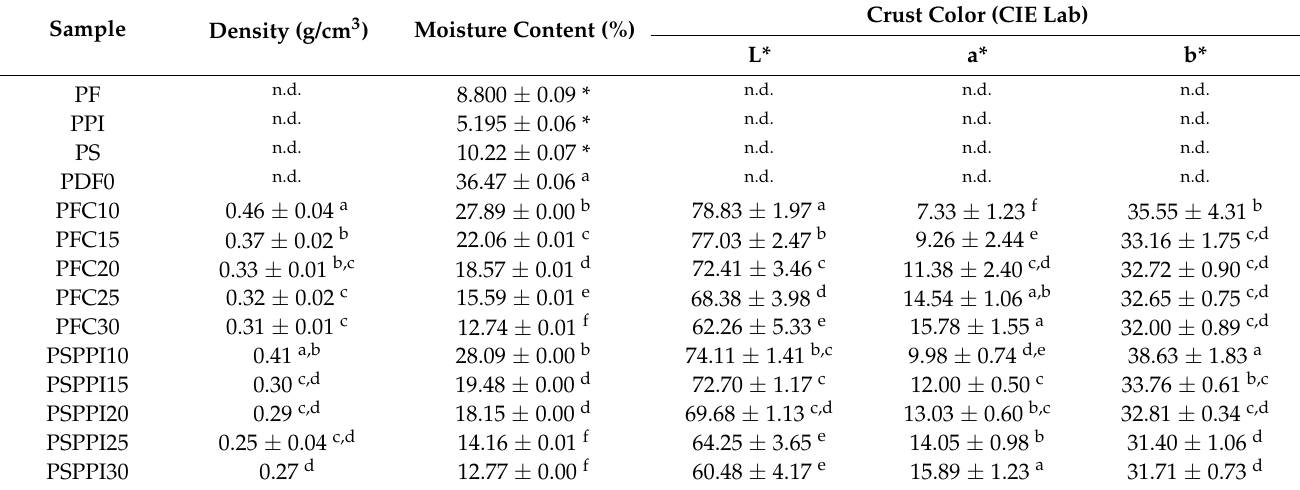
Table A1. Tukey’s HSD test was used as a post hoc analysis to group the statistically significantly different means. Significantly different means ( p < 0.05) are represented by letters in exponent.